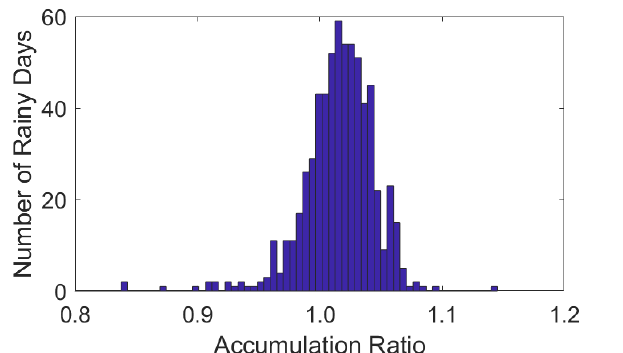
Figure 7. The frequency of accumulation ratios between the corrected and raw daily data sets in the ensemble; a value of 1.1 suggests that the corrected accumulation is 10% larger than the original reported accumulation. Small net corrections of less than 5% appear typical.